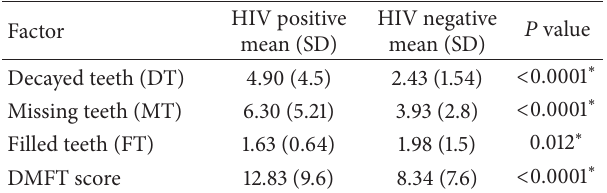
Table 2: Dentition status of the HIV positive and negative group.